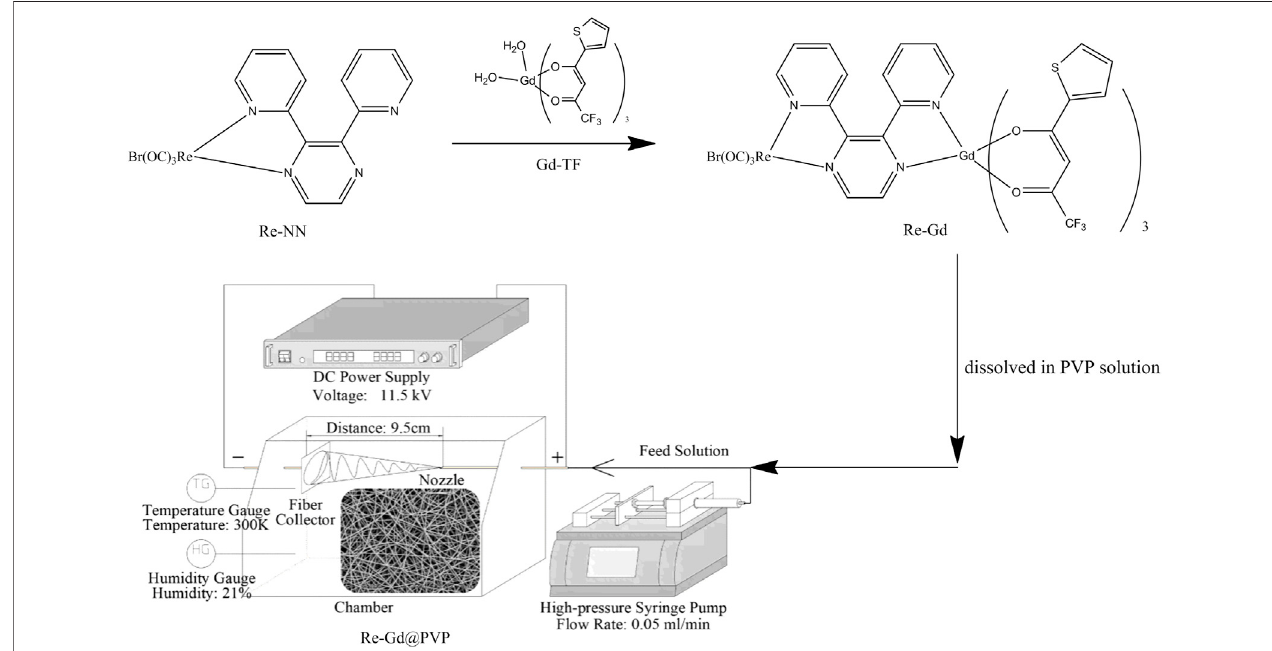
SCHEME 1 | A schematic route for the synthesis of Re-Gd photosensitizer and Re-Gd@PVP fi